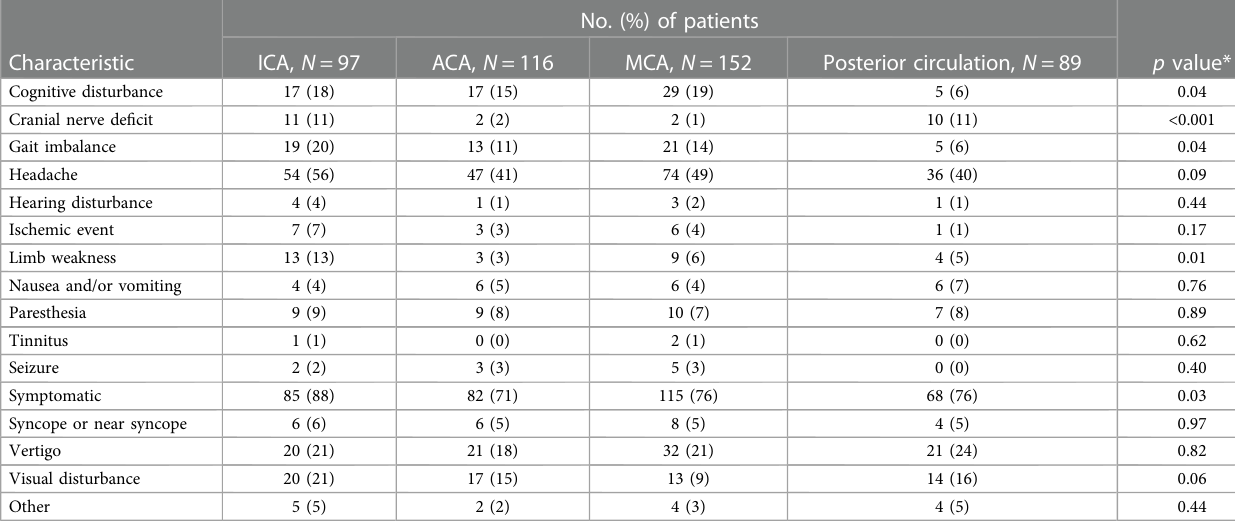
TABLE 5 Symptoms among 454 patients with unruptured intracranial aneurysms, by aneurysm location.